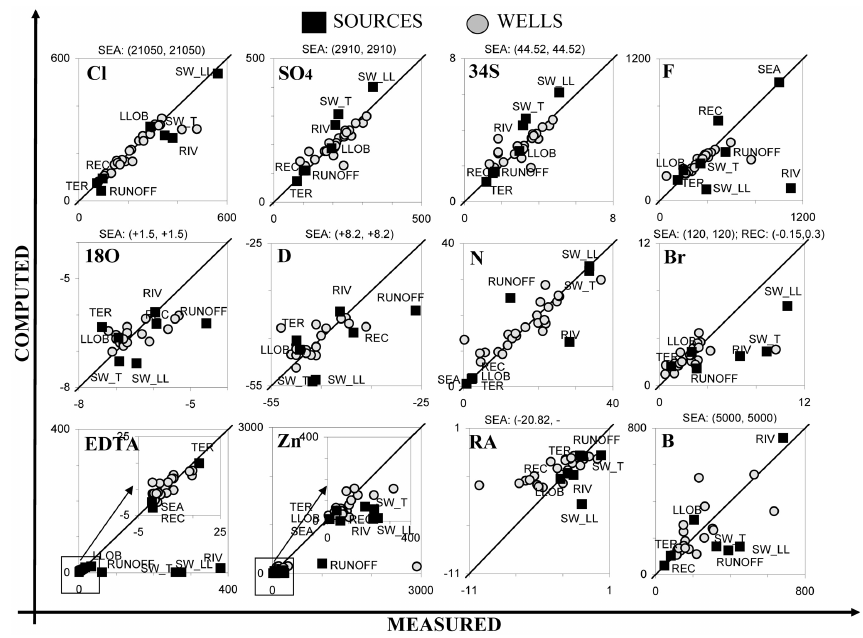
Fig. 7. Computed vs. measured concentrations of all species at all end-members and well samples. Notice the significant reductions of Cl, F, N, Br and EDTA concentrations at the river end-member, which probably reflects the fact that river recharge occurs mainly during floods. Notice also the non conservative behavior of EDTA (end-member concentrations need to be drastically reduced), RA (mixed samples RA need to be increased) and, to some extent, Zn and